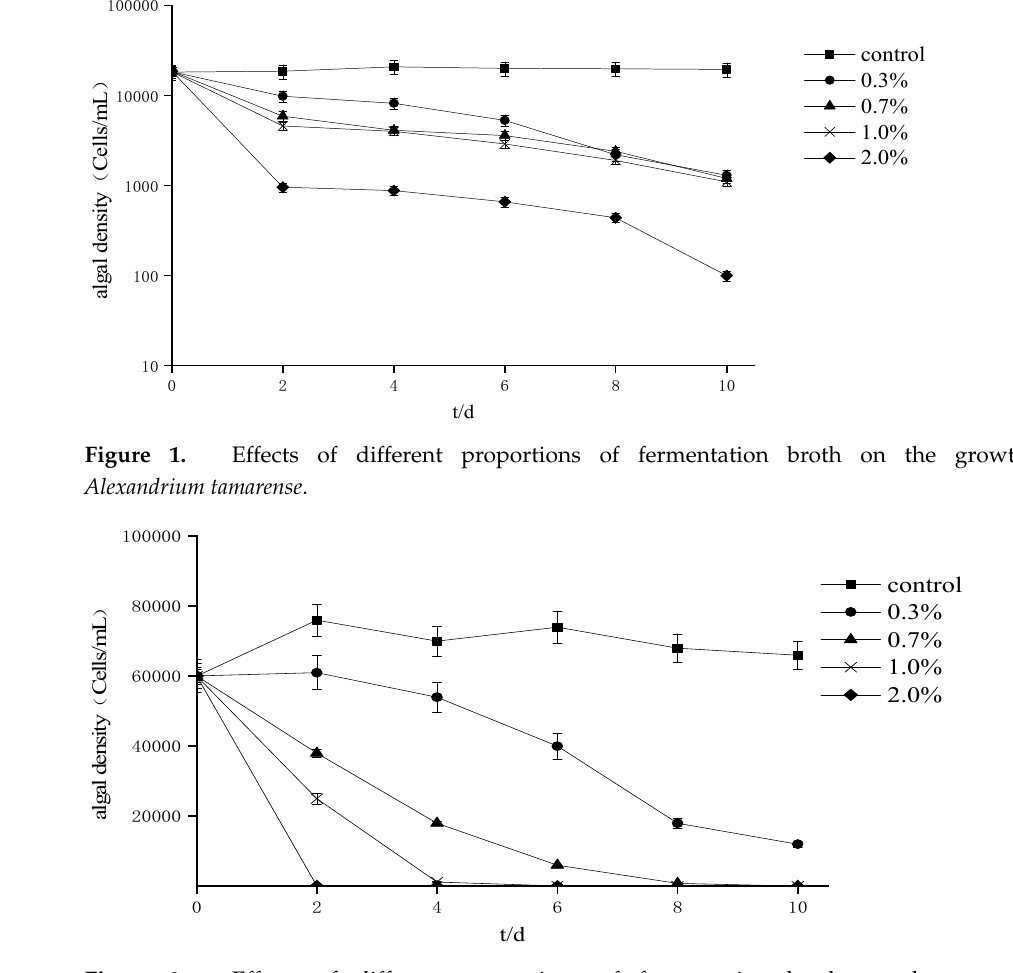
Figure 2. Effects of different proportions of fermentation broth on the growth of Prorocentrum donghaiense . Table 1. Correlation analysis results show that the treatment time and the different cell densities of red tide